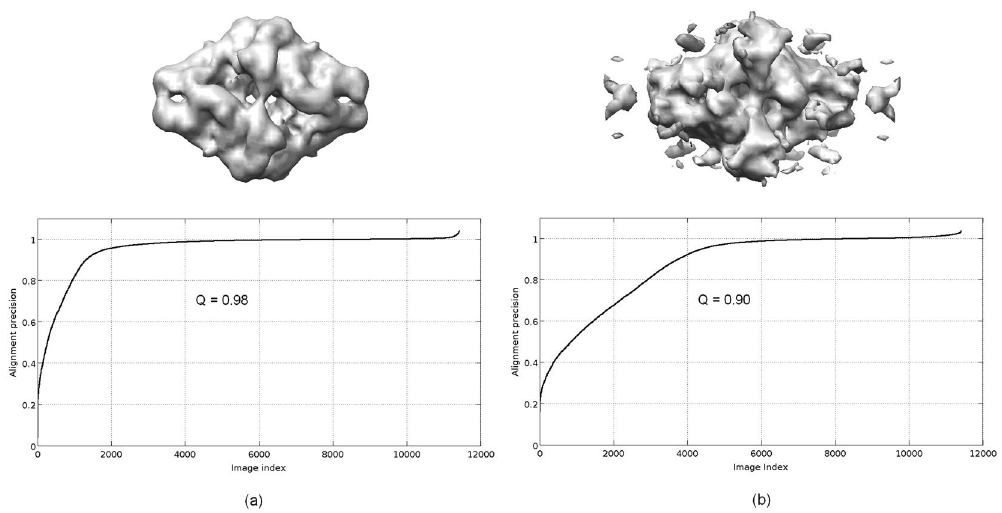
Figure 9. Alignment precision curves computed from the “good” ( a ) and “bad” quality ( b ) ab initio β -galactosidase initial